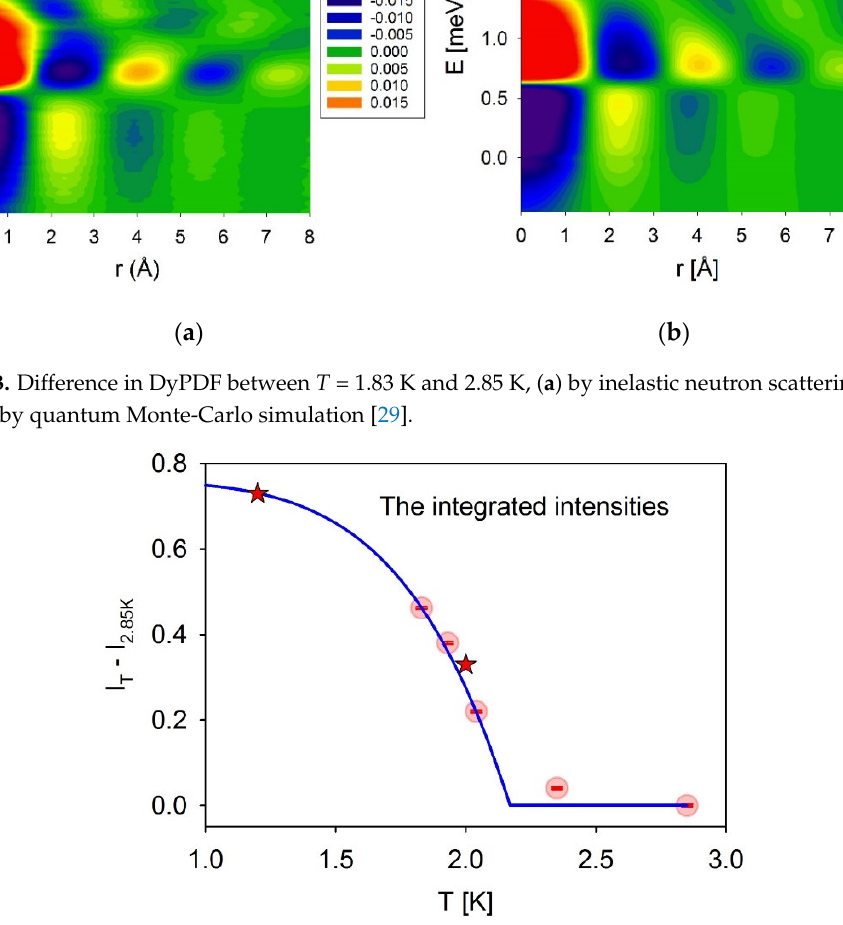
Figure 4. Temperature dependence of the DyPDF intensity at 0.7 meV and 4 Å, by INS (circles) and by quantum Monte-Carlo simulation (stars) [29]. The solid line describes that of the superfluid order parameter [27].